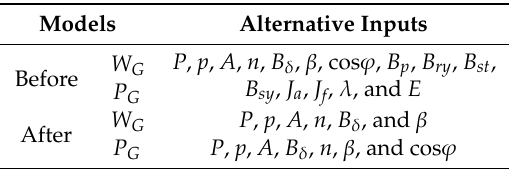
Table 2. Candidate variables for simplified models.